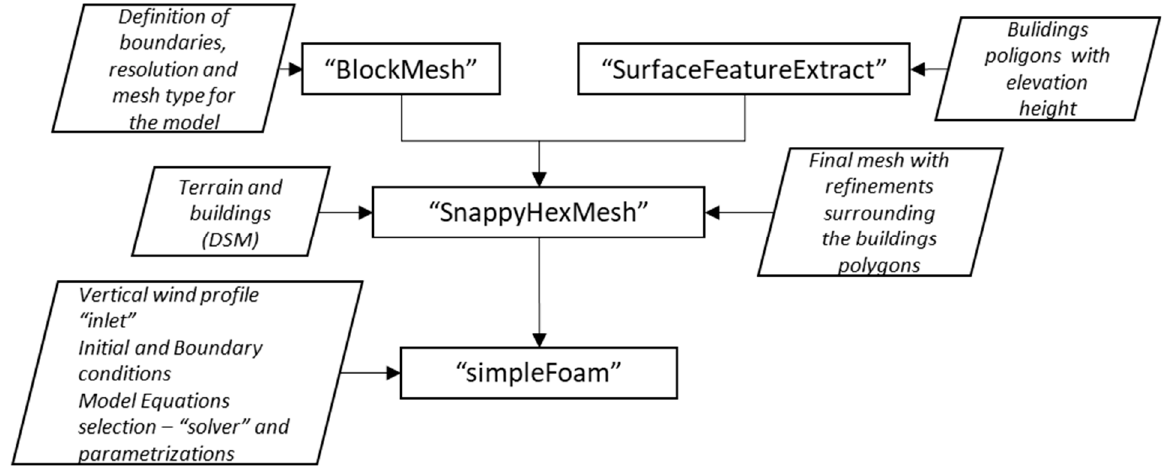
Figure 7. Schematic workflow for performing a simulation with the OpenFOAM model.